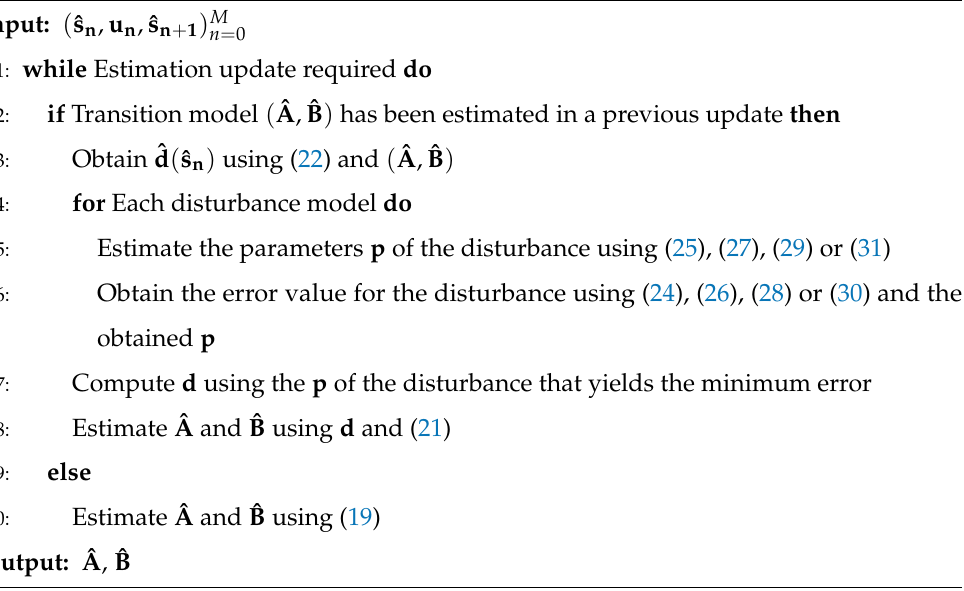
Algorithm 1 Joint transition and Full Disturbance Estimator (FDE)